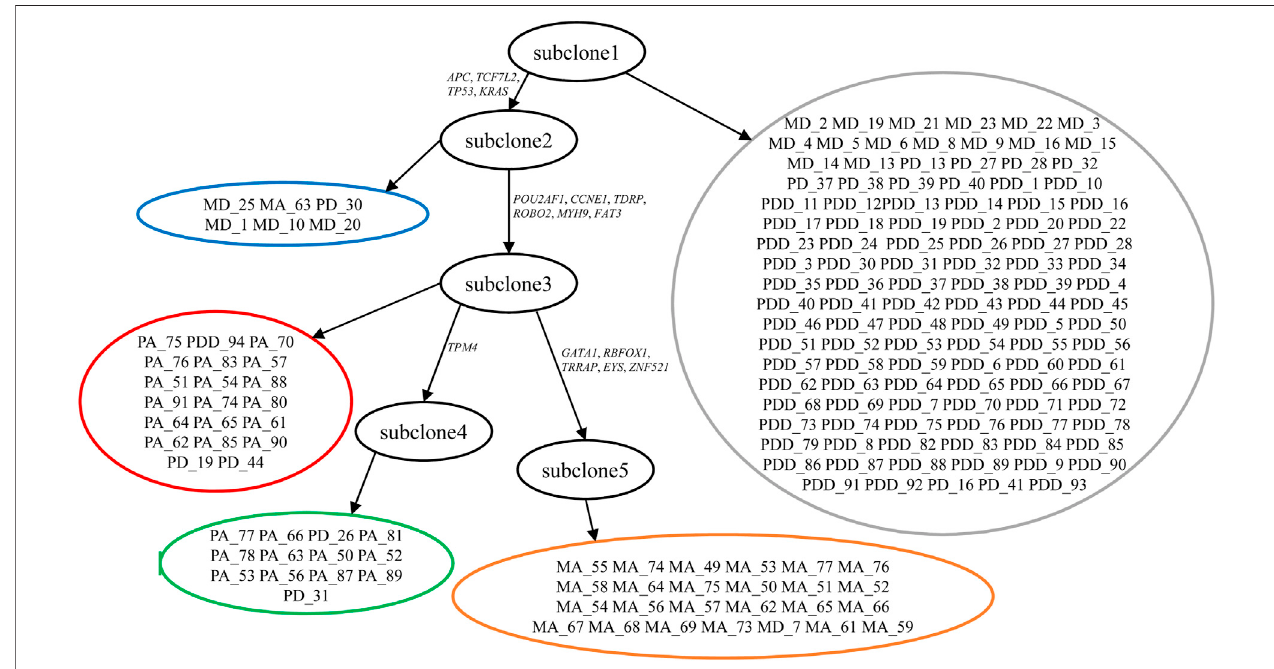
FIGURE 8 | Subclones and their lineage relationship inferred from metastatic colorectal cancer dataset. SCClone identi fi es fi ve subclones. subclone1 represents normal population without mutations, subclone2 consists of mutated diploid cells, subclone3 and subclone4 are constituted by primary aneuploid cells, and subclone5 represents metastatic aneuploid cells. The estimated FPR α and FNR β are 0.96 and 14.46%,